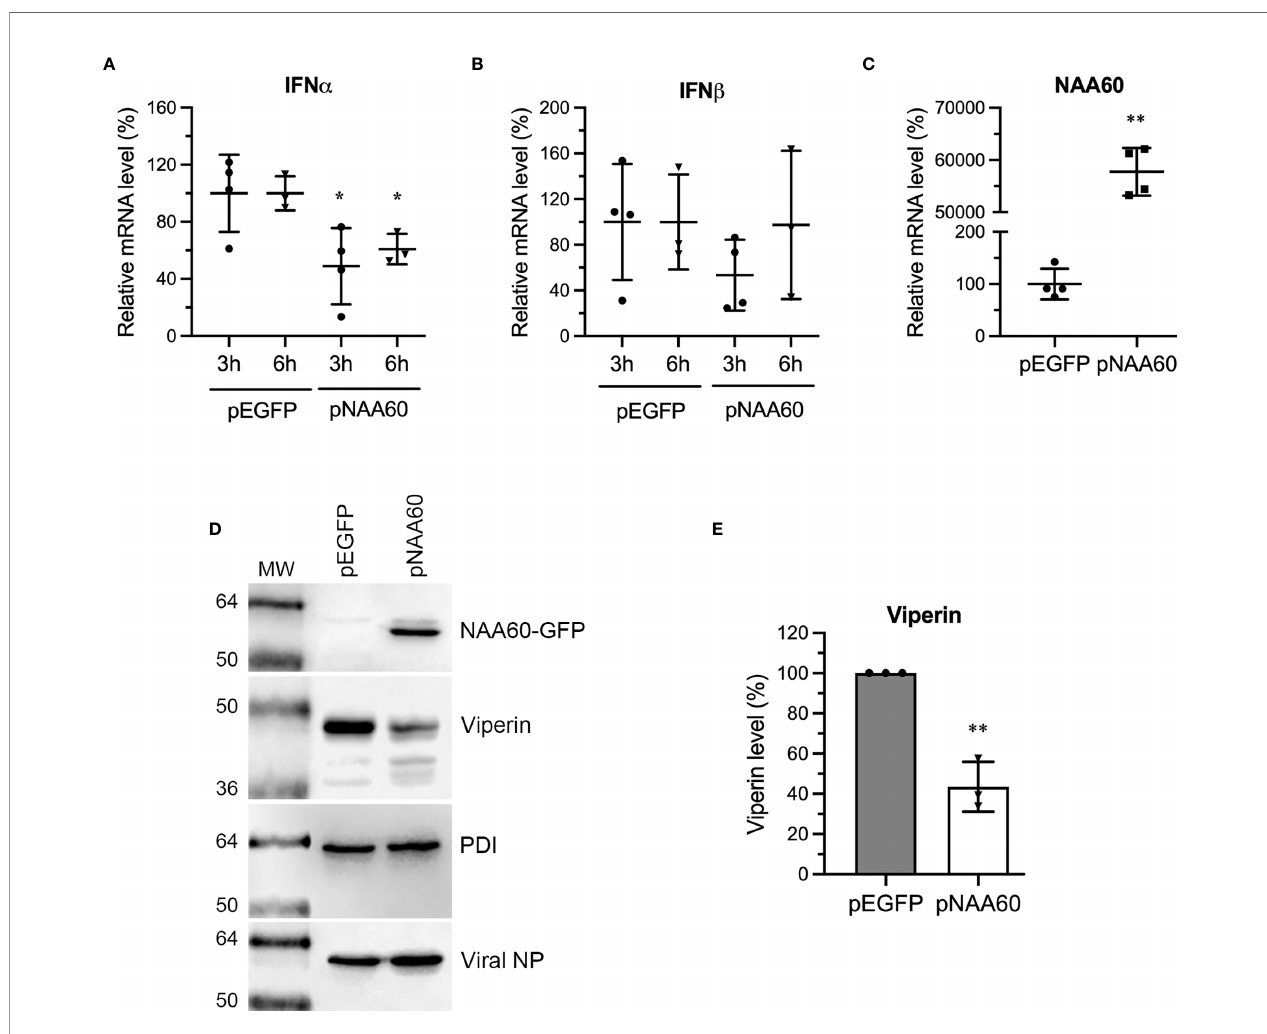
FIGURE 7 | The overexpression of NAA60 decreases IAV-induced IFN a and viperin expression. HEK293T (A – C) and A549 (D, E) cells were transfected with 1µg of pEGFP or pNAA60 plasmid for 24 h. (A – C) One set of the cells was processed to con fi rm the overexpression of NAA60 by RT-qPCR (C) as in Figure 1A . The other set of the cells was infected with PR8 at an MOI of 1.0 for 3 h or 6 h, and the cells were processed to detect and calculate the mRNA level of IFN a (A) and IFN b (B) by RT-qPCR as in Figure 1A . (D, E) A549 cells were infected with PR8 at an MOI of 1.0 for 24 h and processed to detect the NAA60-GFP, viperin, viral NP and PDI polypeptide levels by western blotting (D) . The intensity of viperin bands was quanti fi ed and normalised with the intensity of corresponding PDI bands. The normalized value of viperin in pEGFP transfected cells at each timepoint was considered 100% to determine its amount in pNAA60 transfected cells (E) . Error bars represent means ± standard deviation of at least three biological replicates; **P ≤ 0.01, *P ≤ 0.05. MW, molecular weight; Grey bar, CTRL; White bar,